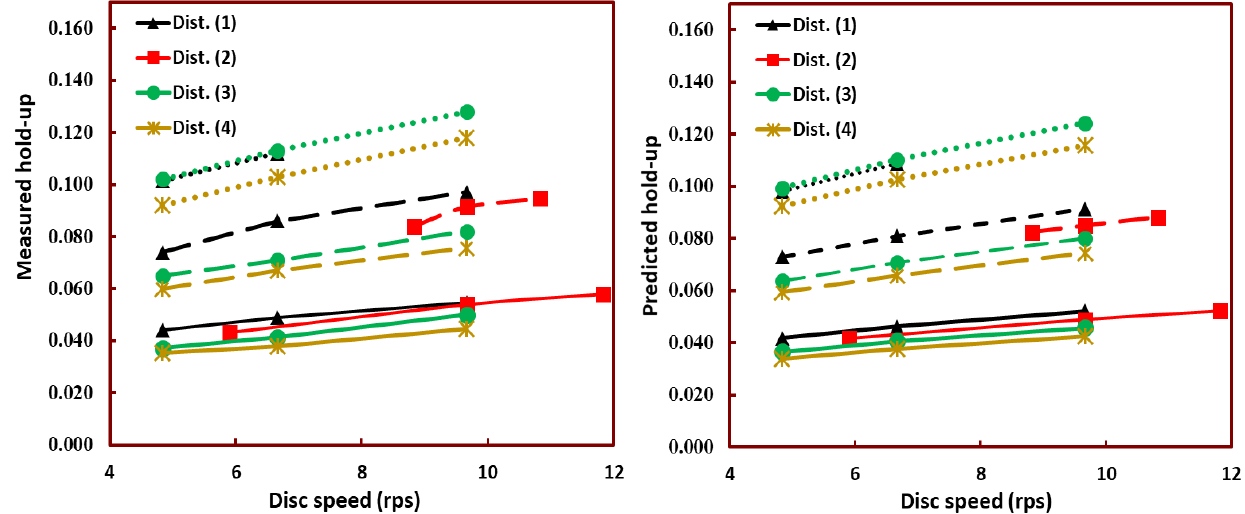
Figure 5. Dispersed phase holdup versus disc speed for the experimentally and theoretically predicted values. Low total flowrate (solid lines), medium total flowrate (long dash lines), high total flowrate (dotted lines).